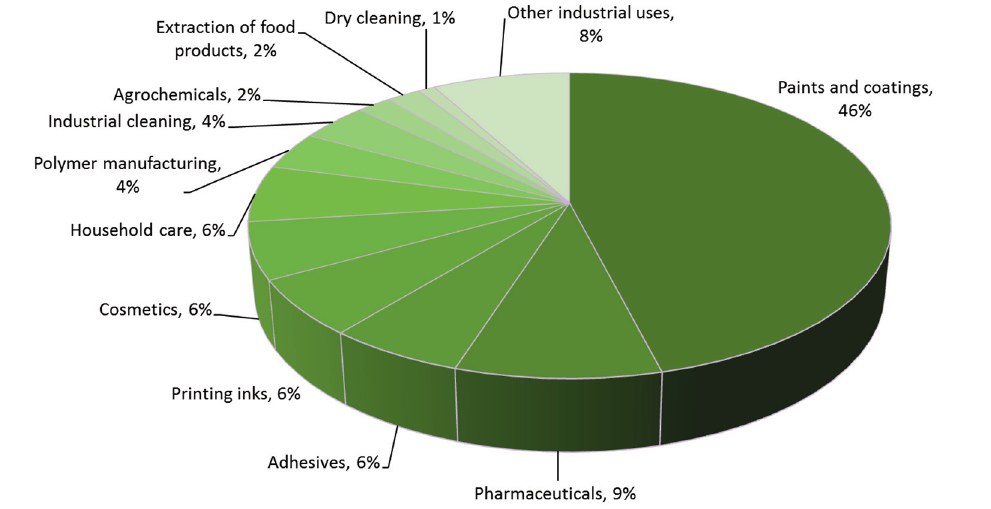
Figure 2. Solvent use arranged by